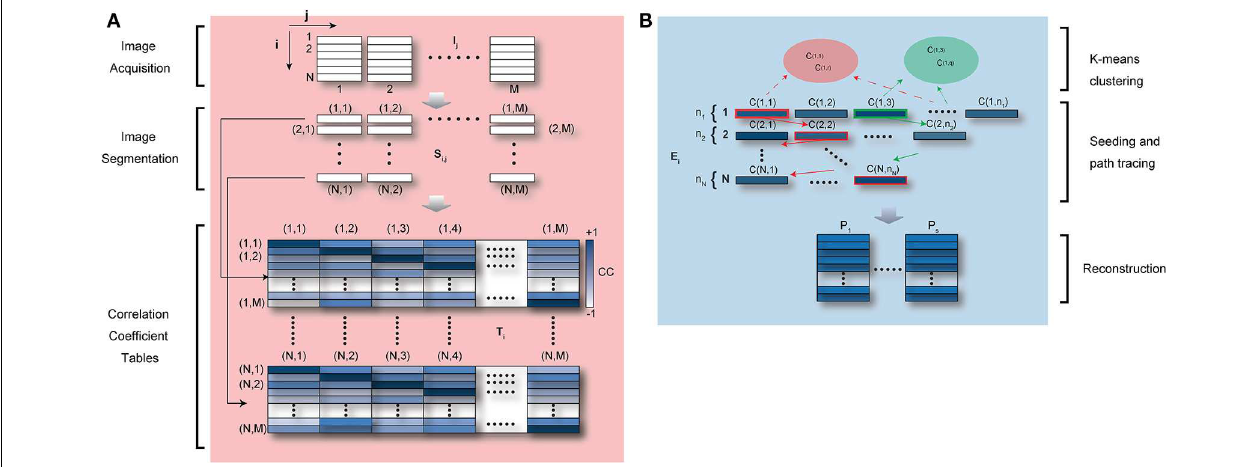
FIGURE 11 | Schematic diagram of automatic artifact removal and image reconstruction algorithm. (A) M raw images, which include in-frame motion artifacts “locally” or “globally,” are divided in N segments. AllM segments corresponding to the same temporal position in the image coordinates are collected and the correlation coefficient is calculated between each segment and all the remaining ones. N “segment correlation coefficient tables” are then obtained for each individual segment. In the table, dark color represents high values of correlation coefficient, i.e., similarity